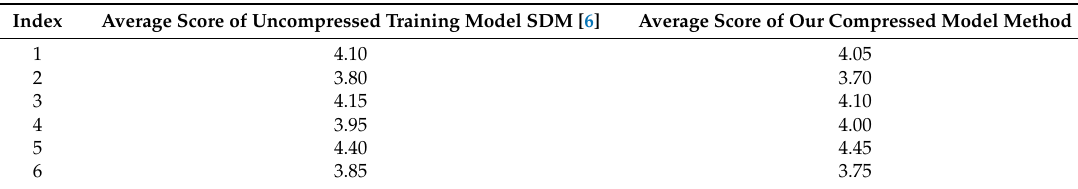
Table 5. Comparisons of average scores for the two methods.